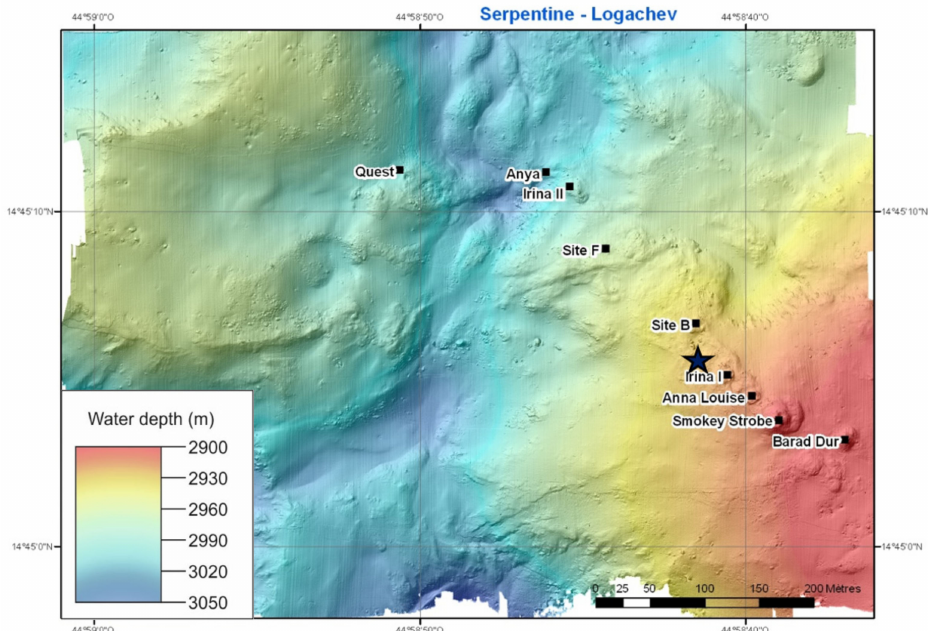
Figure 1. Position of the CTD sounding station (star) at the Irina 1 crater, Logachev field. The bathymetric map was obtained by the ROV Victor 6000 near-bottom multibeam survey during the SERPENTINE cruise [8].